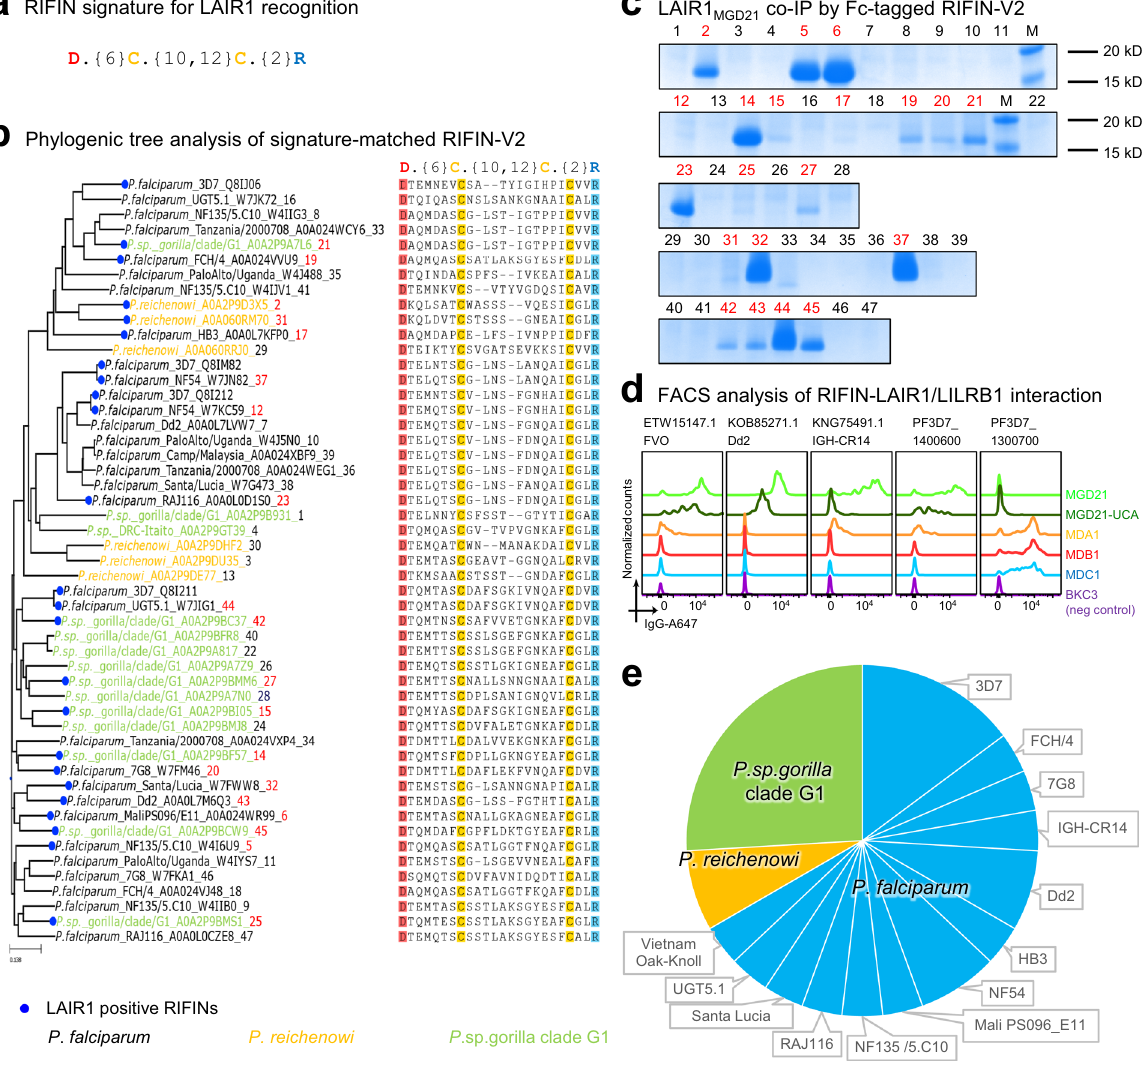
Fig. 4 Signature-based search identi fi es LAIR1-binding RIFINs from Plasmodium sequences. a Structure-based delineation of LAIR1 binding signature on RIFIN. b Phylogenic tree of V2 domain showing name and apex sequences of signature-matched RIFINs. Blue circles indicate the empirically con fi rmed LAIR1-positive RIFIN. Ape-infecting strains are highlighted in yellow or green, and P . falciparum strains in black. The number at the end of each name indicates its sequence in ( c ). c Coomassie blue-stained SDS-PAGE showing LAIR1 MGD21 co-immunoprecipitation (Co-IP) by Fc-tagged RIFIN-V2 constructs identi fi ed by the signature. Con fi rmed LAIR1-binding RIFIN ID are highlighted in red. Lanes marked with “ M ” are molecular ladders showing 15 – 20 kDa bands. The SDS-PAGE runs were repeated at least twice. d FACS analysis example of RIFIN-LAIR1 (MGD21 and MGD21-UCA) or RIFIN-LILRB1(MDA1, MDB1, and MDC1) interaction. e Pie chart summary of 27 experimentally con fi rmed LAIR1-positive RIFINs, colored by three Plasmodium species ( P. falciparum and two ape-speci fi c